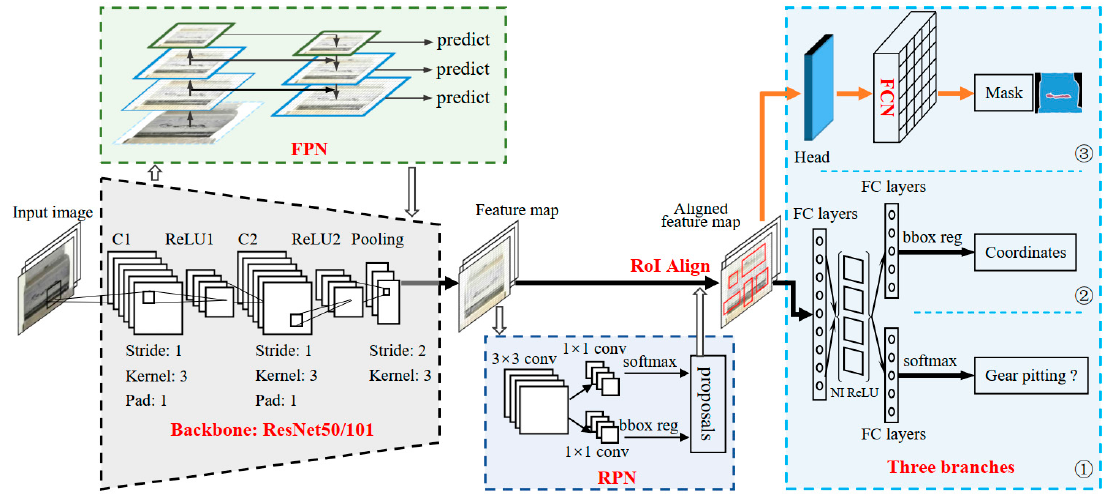
Figure 7. Structure of the deep mask region-based convolutional neural network (Mask R-CNN).